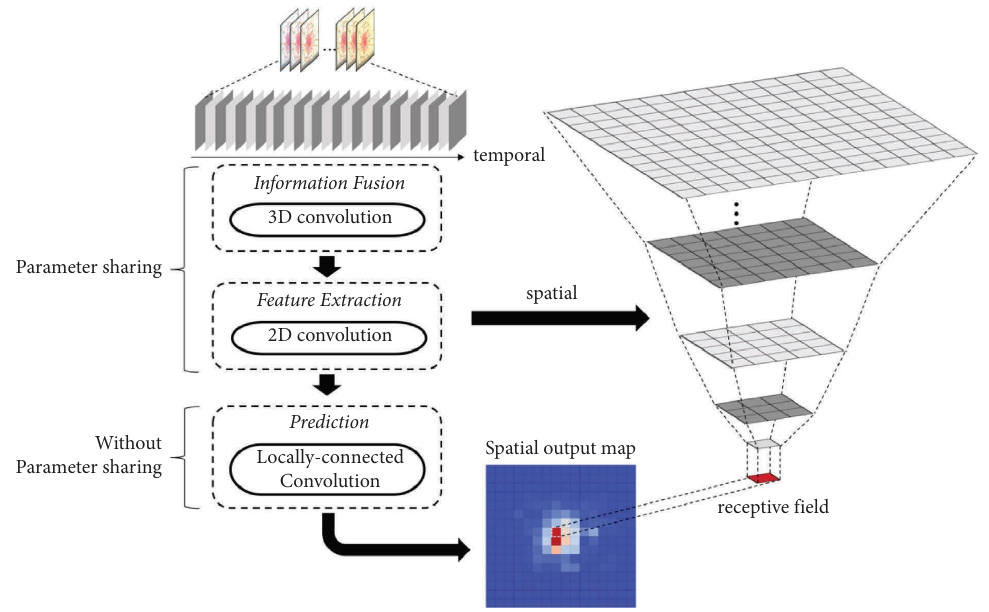
Figure 1: End-to-end implementation of the LC-ST-FCN